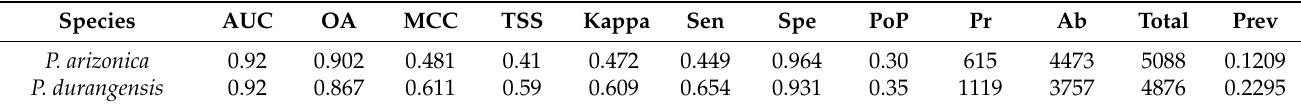
Note: AUC = Area under the receiver operating characteristic curve, OA = Overall accuracy, MCC = Matthews’ correlation coeffi- cient, TSS = True skill statistic, Kappa = Cohen’s kappa coefficient, Sen = Sensitivity, Spe = Specificity, PoP = Probability of presence, Pr = Presences, Ab = Absence, Prev = Prevalence.